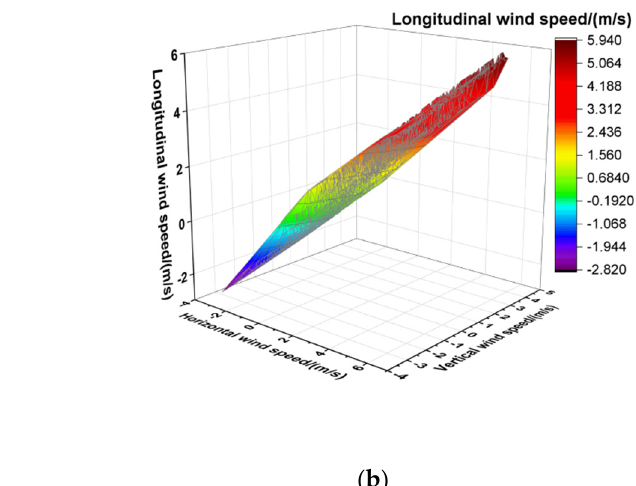
Figure 8. The contrast of standard deviation of simulated points between being corrected and uncorrected: ( a ) One-di- mensional space; ( b ) Two-dimensional space; The contrast of standard deviation deviation of simulated points between being corrected and uncorrected: ( c ) One-dimensional space; ( d ) Two-dimensional space; The contrast of turbulence in- tensity of simulated points between being corrected and uncorrected: ( e ) One-dimensional space; ( f ) Two-dimensional space.